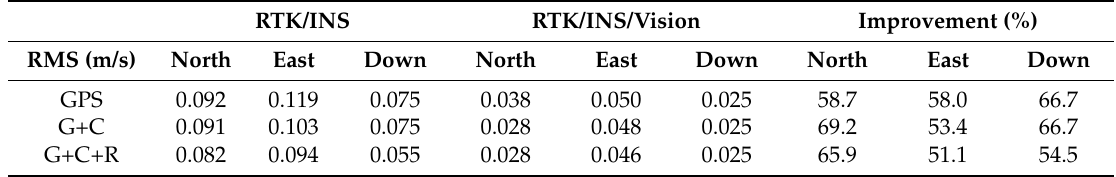
Table 3. RMS of the velocity error of the tightly coupled RTK/INS and RTK/INS/Vision integration for the GPS, GPS + BDS (G+C), and GPS + BDS + GLONASS (G+C+R).